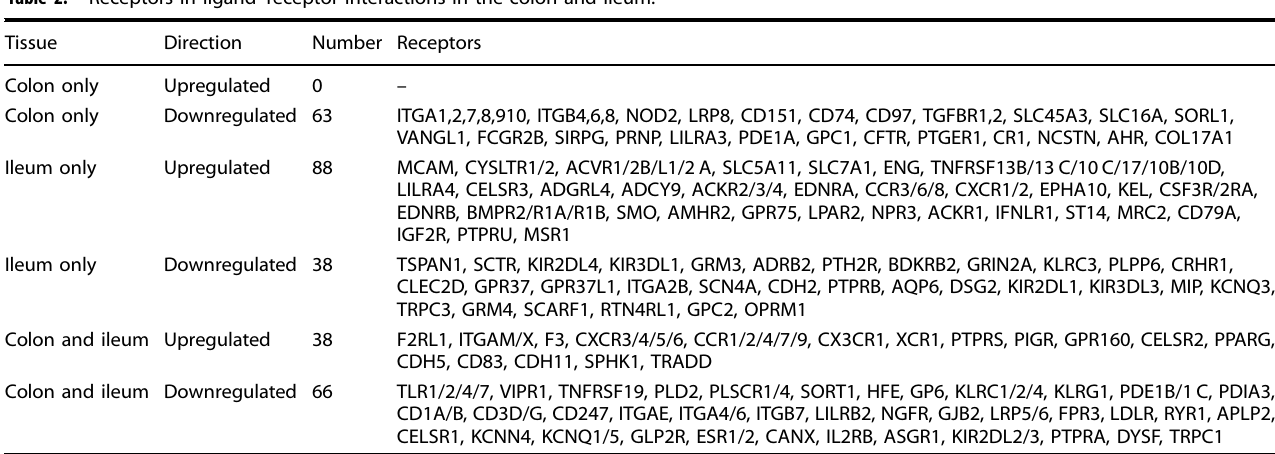
Table listing number of receptors involved ligand – receptor interactions in the infected immature enterocytes – immune cells intercellular network that are unique or shared between the ileum and colon. The direction column indicates the direction of the expression change of the epithelial ligand driving each intercellular